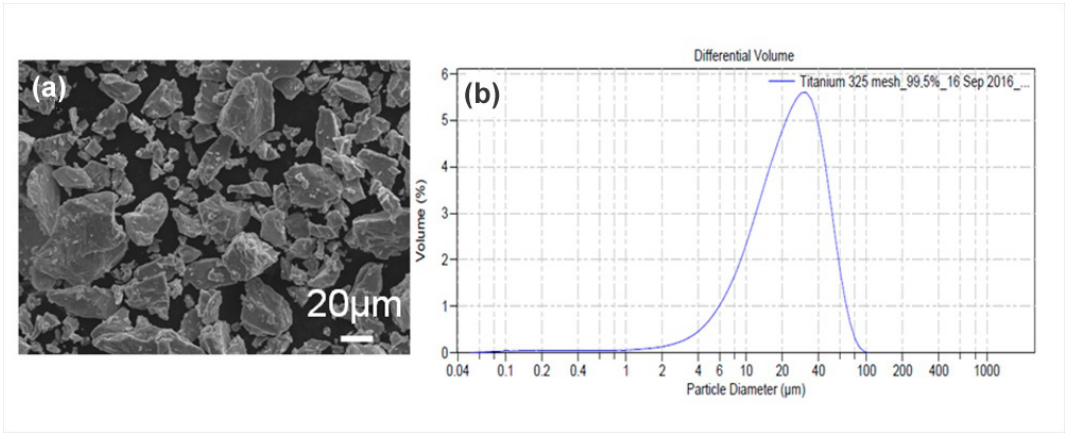
Figure 1. Titanium powder: ( a ) SEM micrograph and ( b ) particle size distribution measured by laser diffraction.